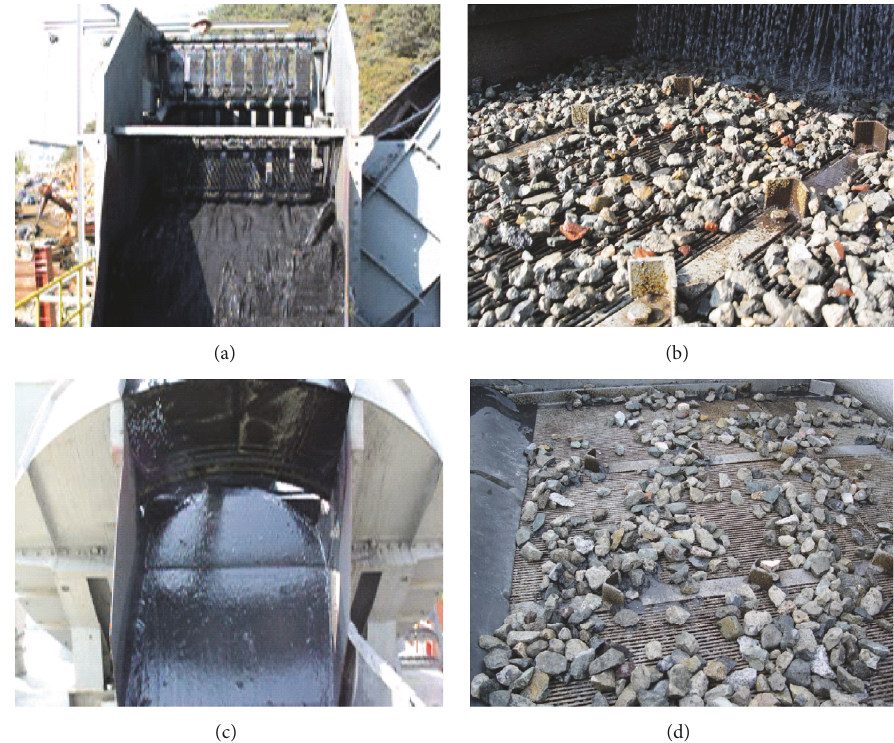
Figure 5: Sink and float particles after the heavy media separation process: (a) outlet of float particles in the drum separator, (b) finished float product after washing, (c) outlet of sink particles in the drum separator, and (d) finished sink product after